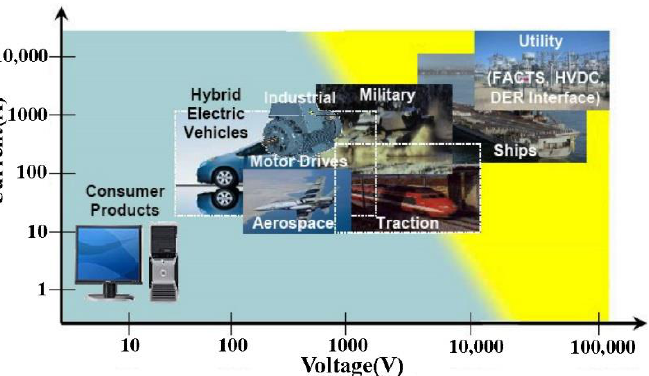
Figure 1. Applications of power electronics in power management and control. Reproduced with